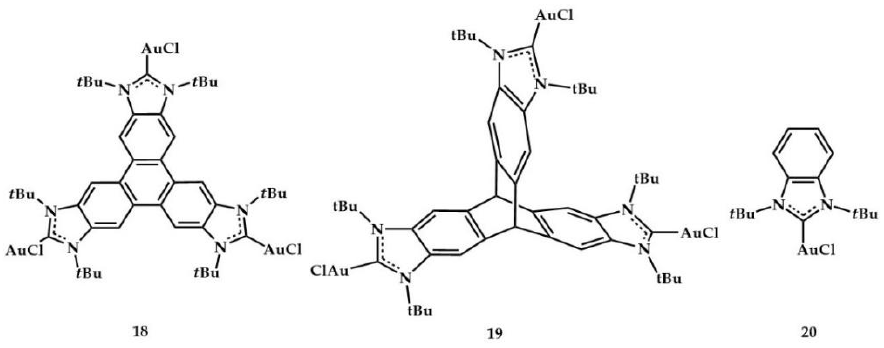
Figure 7. Trimetallic gold 18 and 19 complexes and monometallic 20 complex.